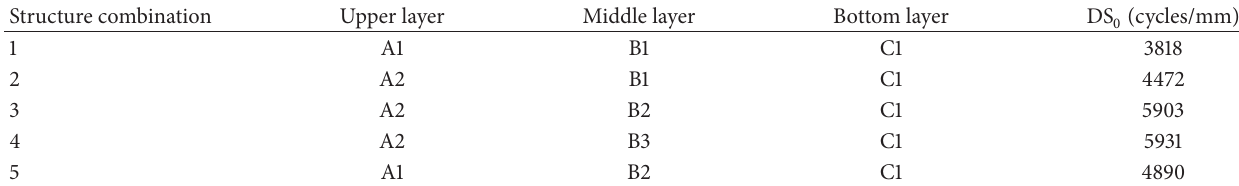
Table 5: Test results for full-thickness rutting of different pavement structures.